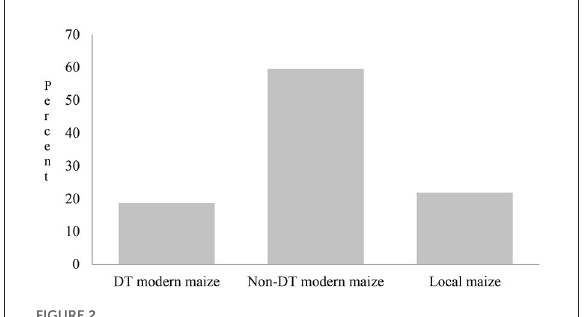
FIGURE2 Percentage of maize plots planted in different types of